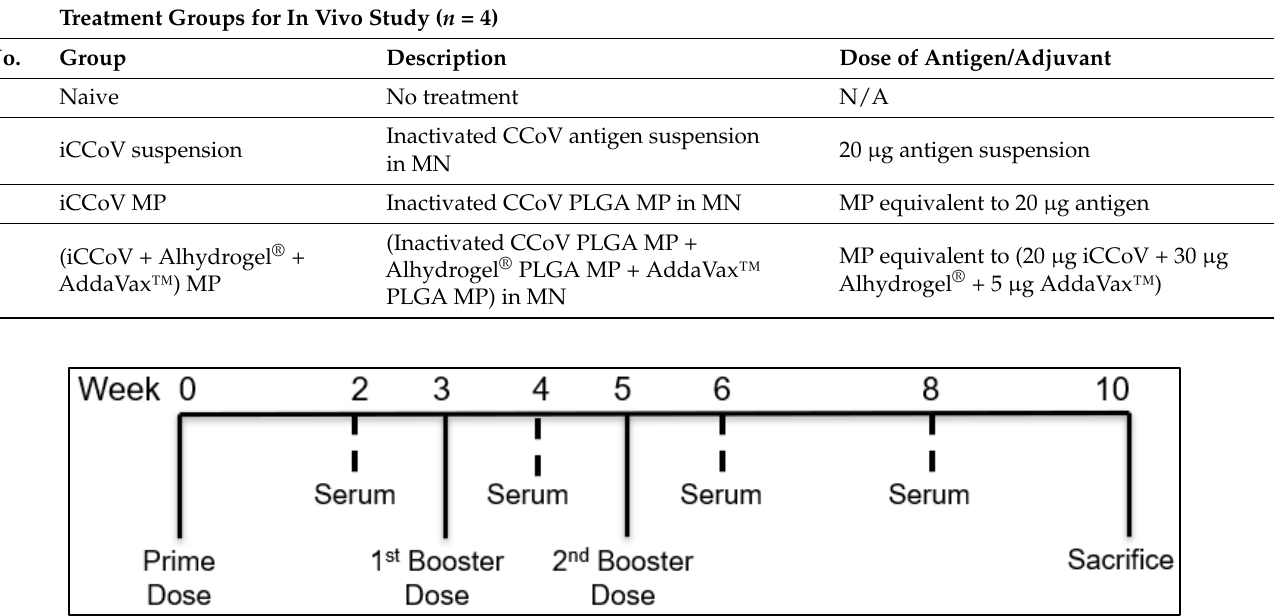
Table 1. Description of treatment groups involved in the in vivo study.